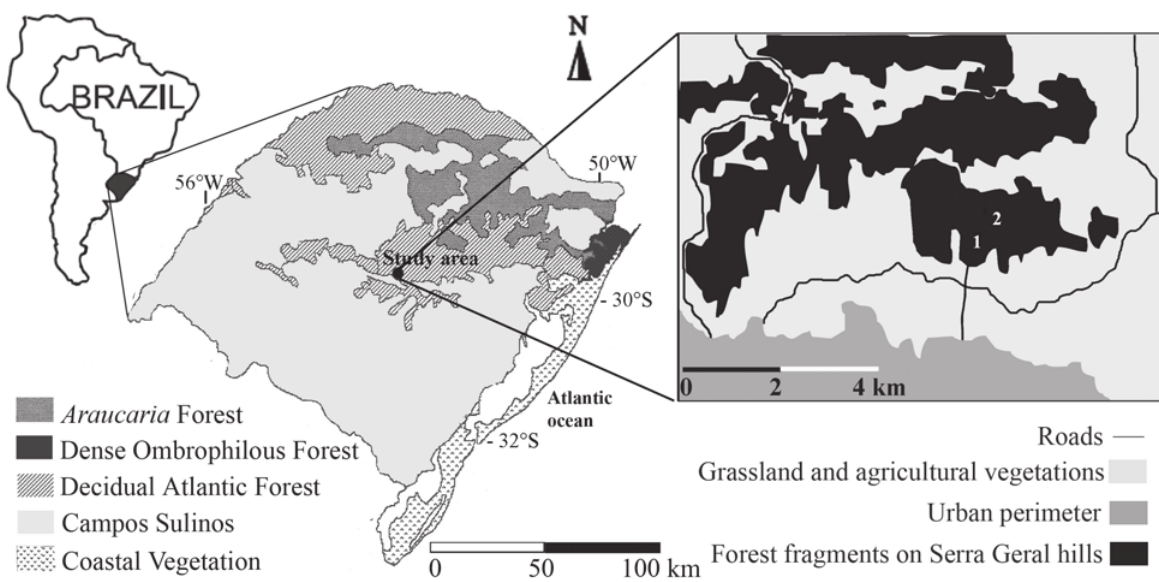
Figure 1. Location of study area in South America and in the state of Rio Grande do Sul, Brazil. The number 1 and 2 are references to the position of each trapping grid in the forest fragment studied, locally named Morro do Elefante .